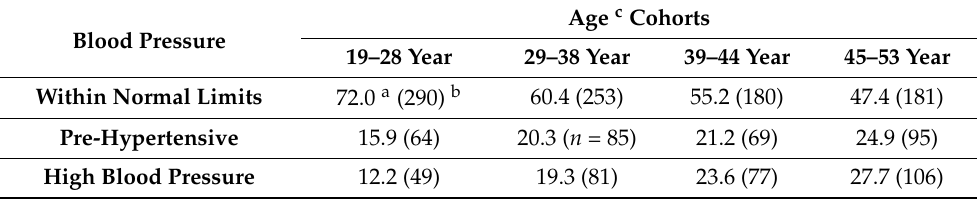
Table 4. Blood pressure and age